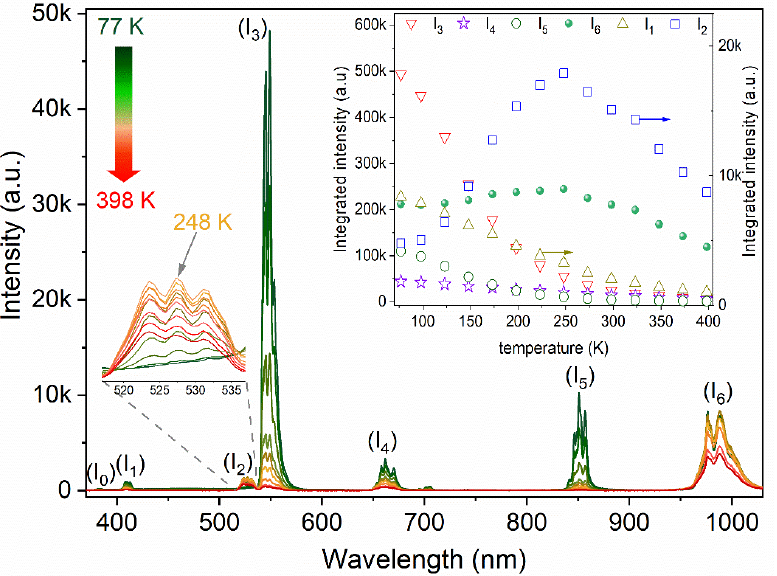
Figure 8. Temperature-dependent emission spectra of La 2 MgTiO 6 :5% Er 3+ excited at 266 nm in the range 77–398 K. Inset: Integrated emission intensity for distinct transitions as a function of temper- ature.